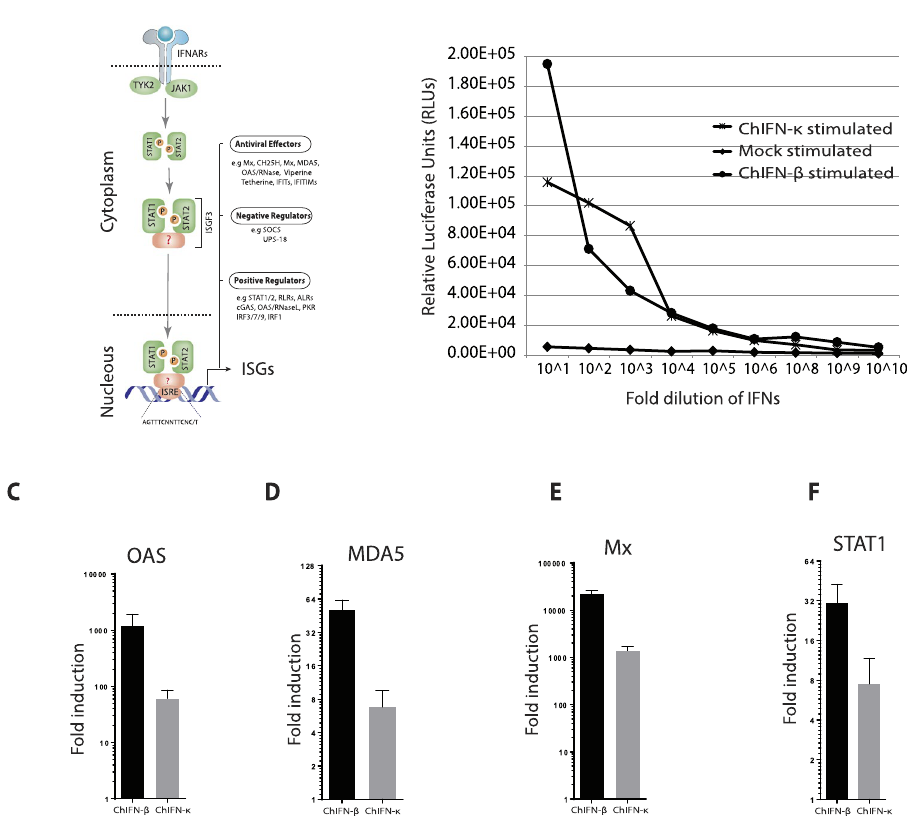
Figure 3. The chIFN- κ induces IFN signalling and transcriptional activation of ISGs in CEFs. ( A) Type I IFNs interact with the IFN receptor complex and initiate the formation of ISGF3 transcription factor through JAK- STAT pathway. Induction of ISGs, which determine the antiviral state of the host, is dependent on the ISGF3 nuclear translocation and interaction with the ISRE promoter (AGTTTCNNTTCNC/T, where N denotes any nucleotide). ( B ) CEF cells were transfected with the Mx-ISRE-Luc (150 ng) and RL-SV40 (10 ng) plasmids for 24 hours in triplicate before stimulation with the serial dilution of chIFN- κ , chIFN- β (expressed in heterologous HEK-293) or media (mock-stimulated) only. The relative luciferase units were determined by the removal of the background and the ratio of Renilla and Firefly luciferase values. ( C–F) Transcriptional profiling of the OAS (C) , MDA5 (D) , Mx (E) and STAT1 (F) genes in the chIFN- κ and chIFN- β treated CEFs. Mock treated cells were used to calculate the fold induction, and mRNA levels of these genes are expressed relative to 28 S rRNA levels. The shown fold induction is average of two independent experiments performed in